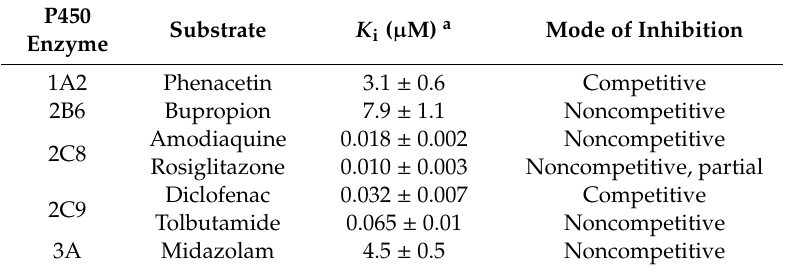
Table 5. K i values for the inhibition of CYP1A2-catalyzed phenacetin O -deethylation, CYP2B6-catalyzed bupropion hydroxylation, CYP2C8-catalyzed amodiaquine N -deethylation, CYP2C8-catalyzed rosiglitazone 5-hydroxylation, CYP2C9-catalyzed diclofenac 4-hydroxylation, CYP2C9-catalyzed tolbutamide 4-hydroxylation, and CYP3A-catalyzed midazolam 1 (cid:48) -hydroxylation in human liver microsomes by selamariscina A. P450